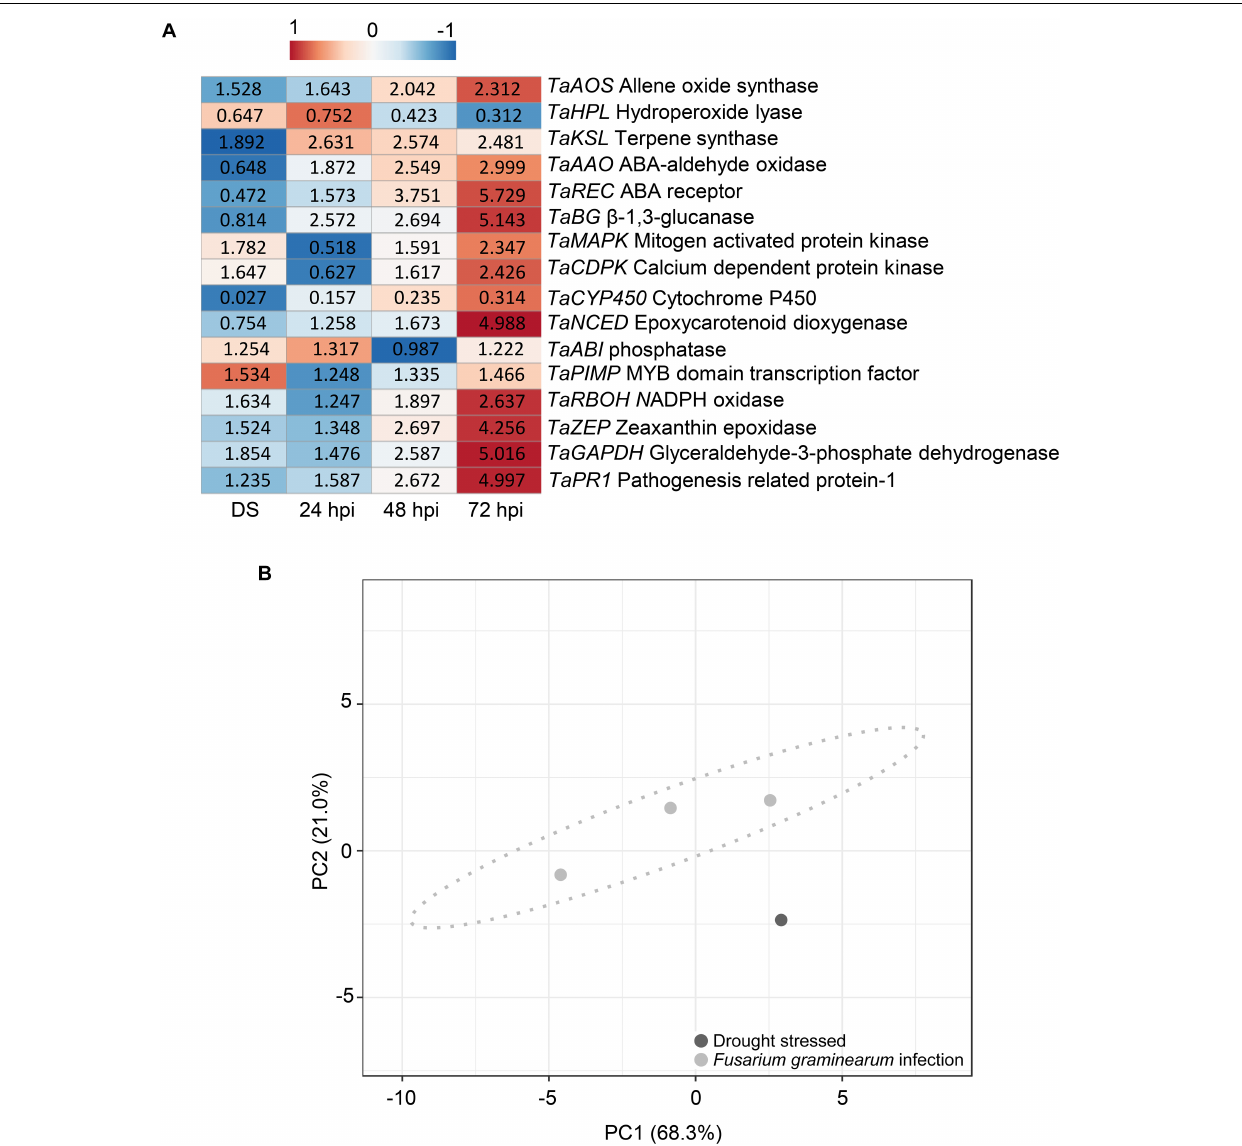
FIGURE 7 | (A) Heatmap of relative expression level of the genes selected in Triticum turgidum (cv. Marco Aurelio) exposed to drought stress (DS) and Fusarium graminearum -inoculated at 24, 48, and 72 hours post inoculation (hpi)) treatments. The expression values were normalized to the mock treatment and to T. aestivum actin ( TaACT ), T. aestivum β -tubulin2 ( TaTUB ), and T. aestivum ferredoxin-NADP(H)-oxidoreductase ( TaFNR ) as reference genes. The heatmap was constructed by plotting the z-score of the relative gene expression values and it was generated by analyzing data with ClustVis Software. The red color represents the up-regulated genes, while the blue color the down-regulated genes. (B) Principial component analysis (PCA) of relative gene expression values, spike temperature and photosynthetic efficiency to distinguish between drought stress and F. graminearum infection during the greenhouse experiments. PCA was performed by using ClustVis Software for p <